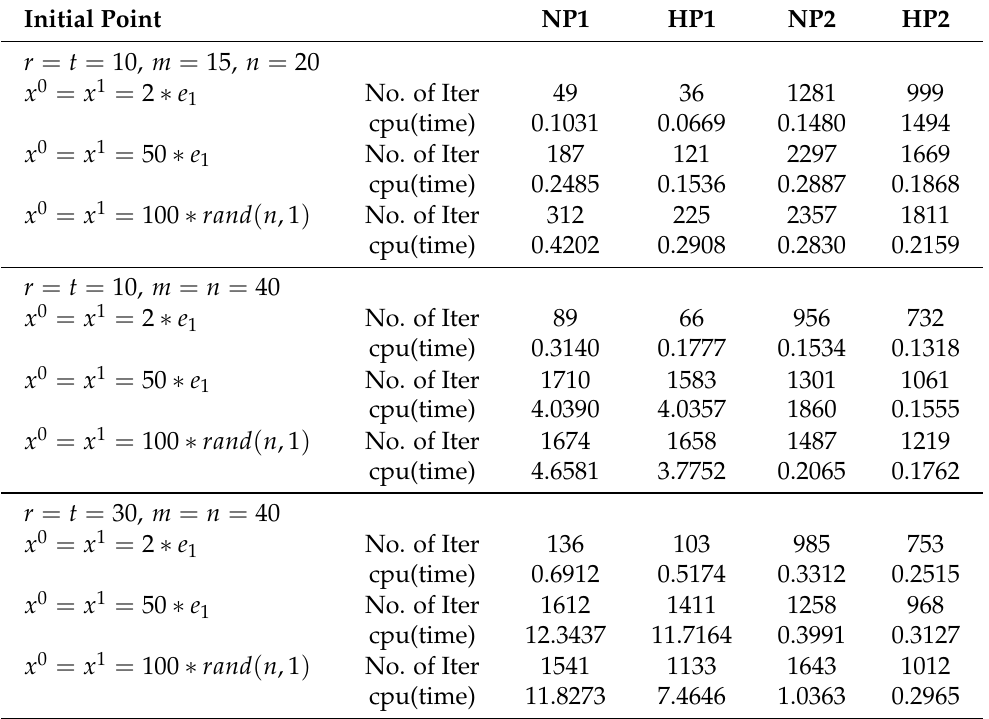
Table 3. Numerical results of the algorithms with and without perturbation for Example